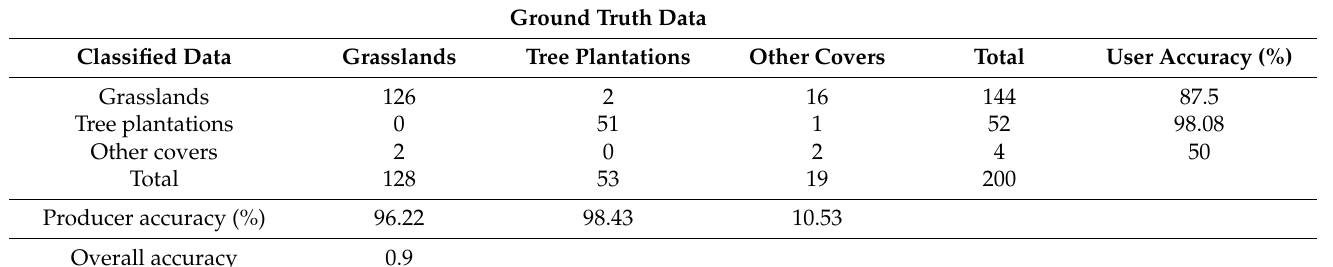
Table A18. Error matrix for the unsupervised classification for the period 2019–2020 based on 200 random points distributed across the Aguapey VGA. The diagonal contains correctly classified